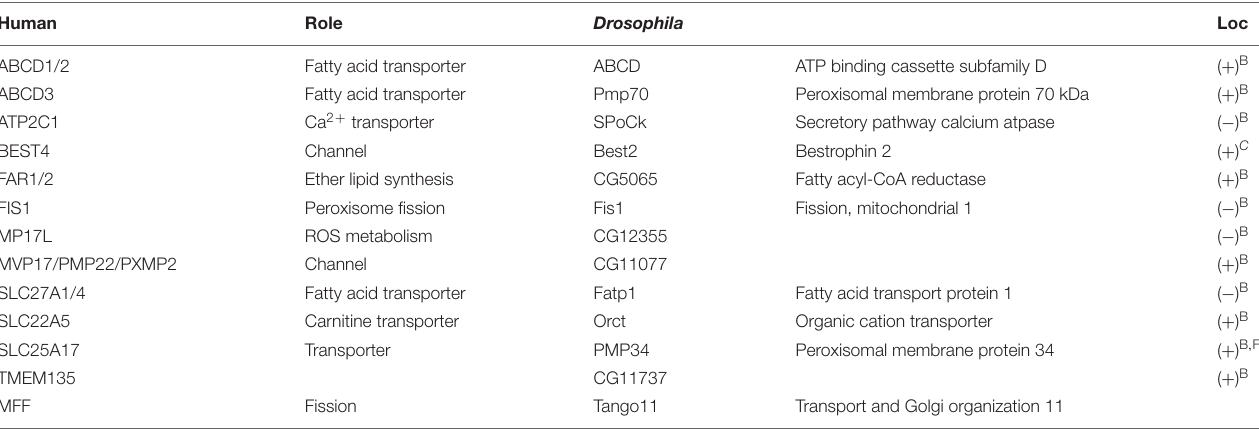
TABLE 2 | Drosophila homologs of known peroxisomal membrane proteins.